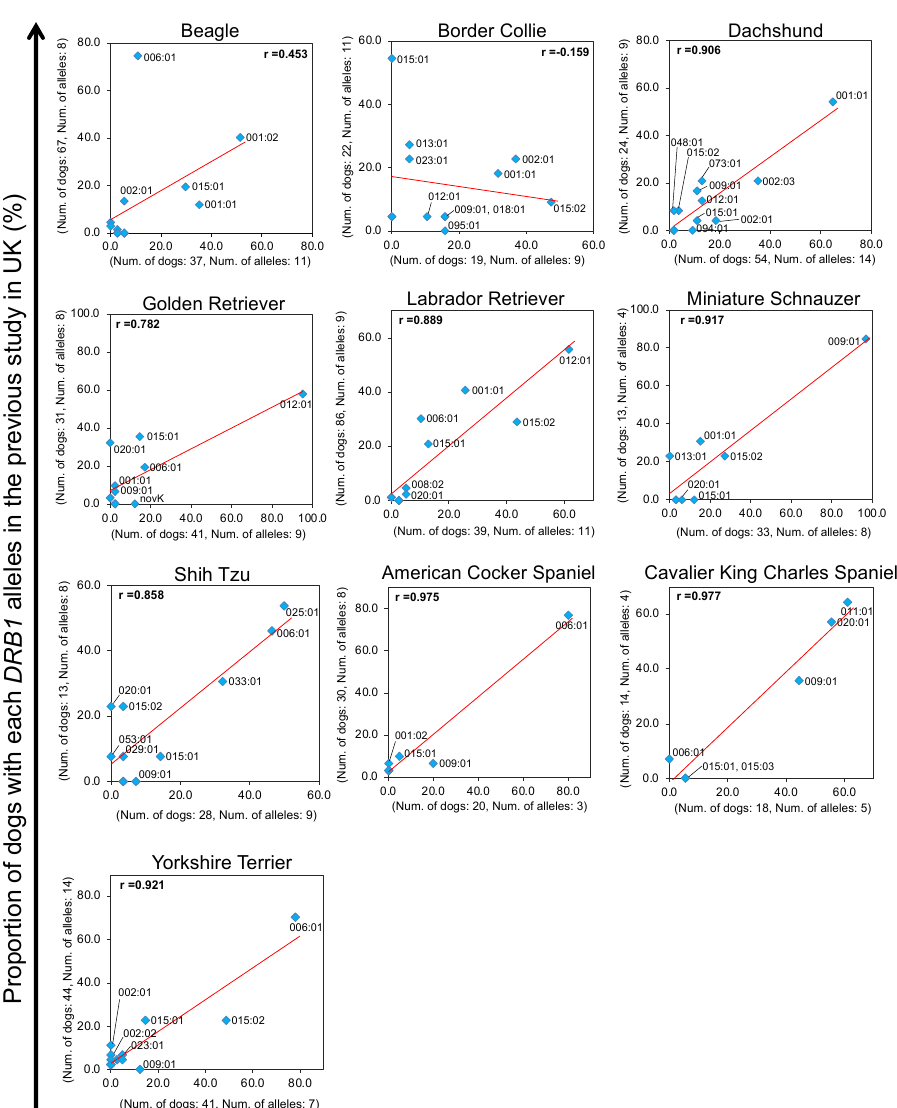
Figure 4. Comparisons of the proportion of dogs with each DLA-DRB1 allele in 10 breeds between the present Japanese and the previous UK study. Scatter plots based on the proportion of dogs with the DLA-DRB1 alleles in ten breeds are shown. The number of dogs analyzed and the number of observed alleles in the present Japanese and the previous UK study are described on the x - and y -axis in each plot, respectively. Dachshunds are summarized without classification by their size, such as miniature or kaninchen, and hair length, such as short or long, in both studies. An allele name is displayed alongside a marker when the proportion is above 5% in either the present or previous study. A red line in each plot represents a regression line. Also, a correlation coefficient (r) is indicated in each plot.